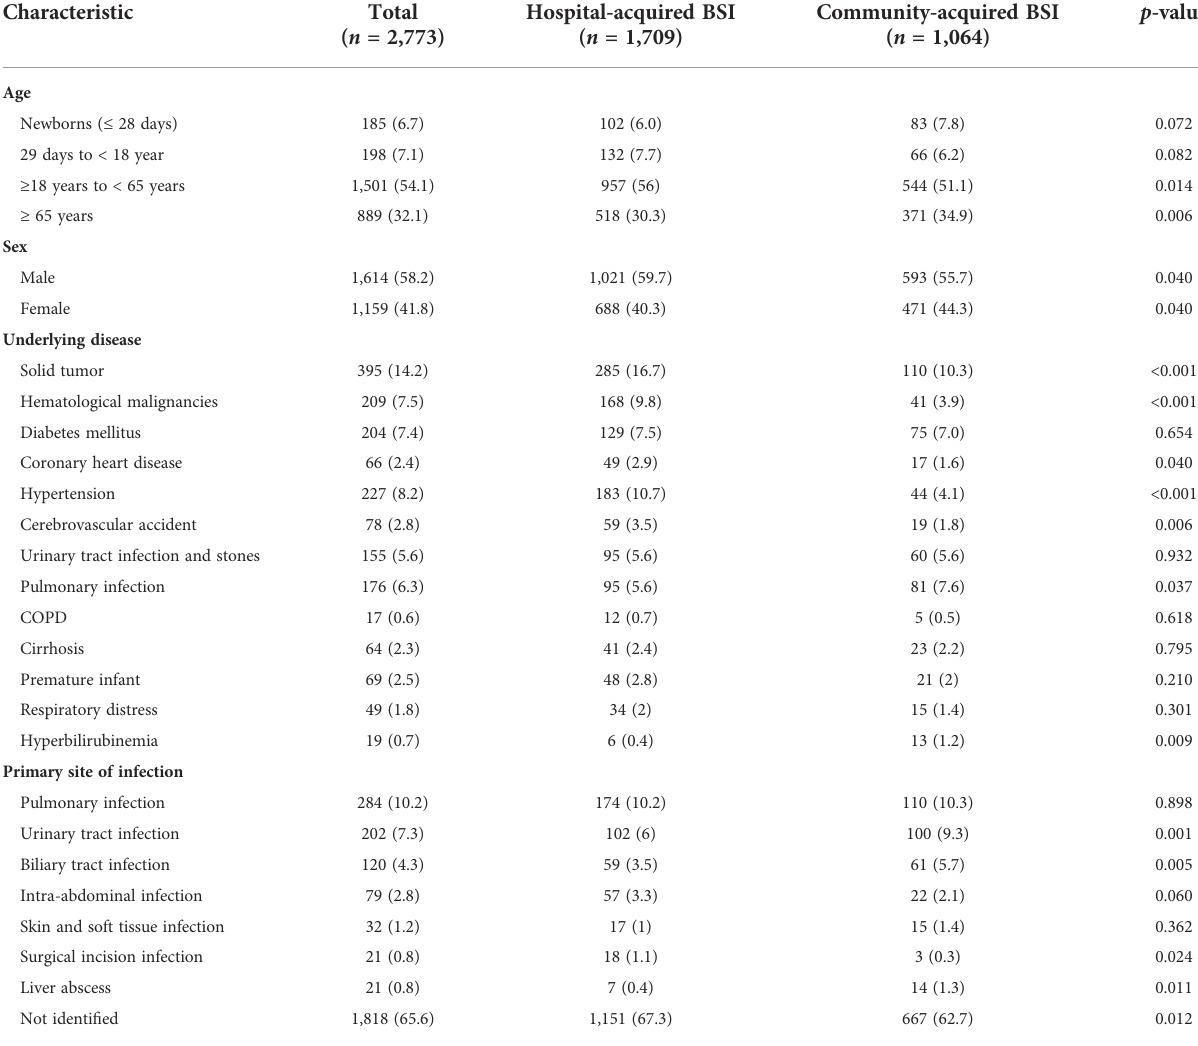
TABLE 1 Demographic and clinical data compared between hospital- and community-acquired bloodstream infections. Characteristic Total